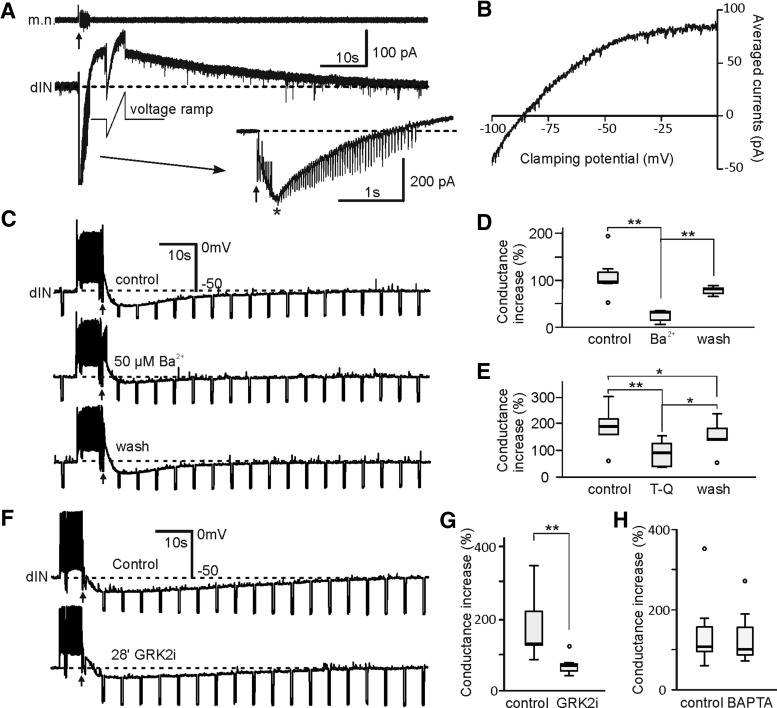
KO inhibition induced by electrical head skin stimulation (arrows) is mediated by GIRKs. A, A voltage-clamp recording shows the slow outward KO current and its onset (inset, *) after KO stimulation (five pulses at 30 Hz). A voltage ramp rising from −100 to 0 mV is applied at the peak of the current. Membrane potential is held at −60 mV at rest. B, I-V data points averaged from five recordings during the voltage ramp in A for estimating the reversal of the currents and their rectification. C, Effects of microperfusing 50 µM Ba2+ on KO inhibition in a dIN. D, Summary of blockade of peak conductance rises by 50–100 µM Ba2+ during KO in two dINs and six non-dINs (paired t tests). E, Microperfusing 3 µM Tertiapin-Q (T-Q) weakened the peak conductance increase during KO in one dIN and five non-dINs (paired t tests). F, One dIN recording with a pipette solution containing 10 µM GRK2i at the beginning (control) and after 28 min of equilibration. G, GRK2i weakened the peak conductance increase during KO inhibition (n = 8, paired t test). H, Summary of peak membrane conductance increase during KO in control and after BAPTA equilibration (n = 8, related samples Wilcoxon signed rank test, p = 0.33). *, significance at p < 0.05 and ** at p < 0.01 in D, E, G. Dashed lines indicate RMP or clamping current at −60 mV in A, C, F.